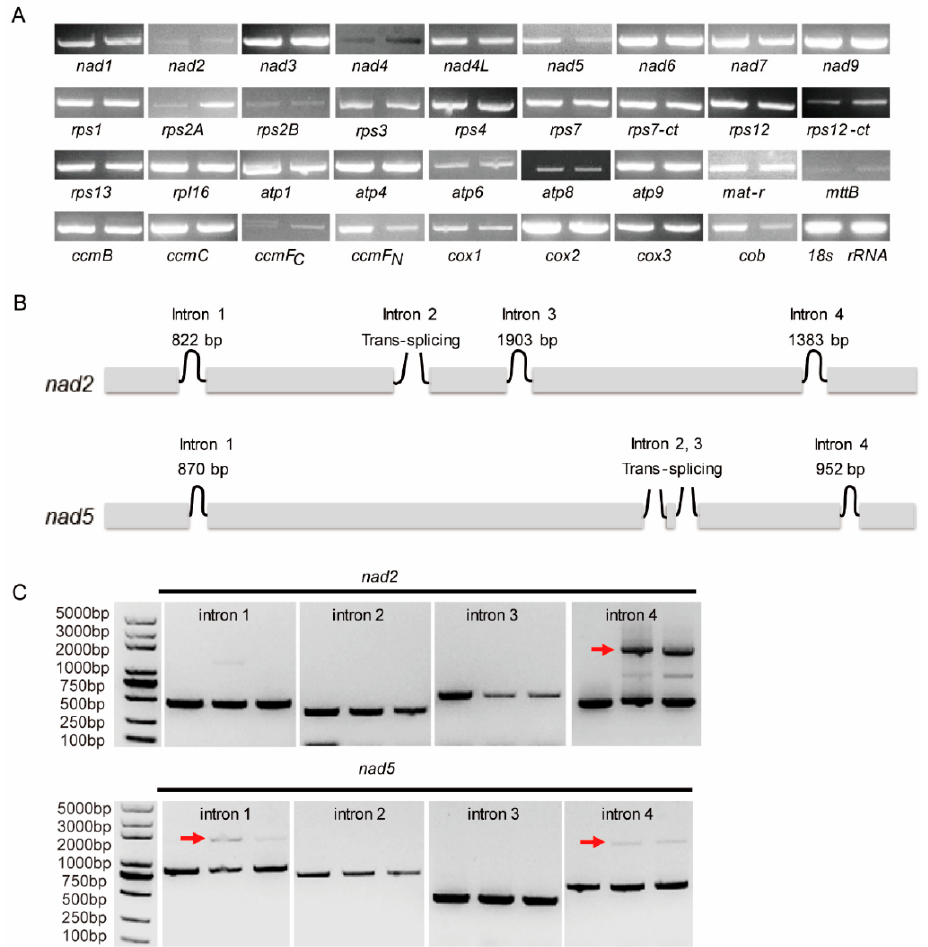
Figure 4. Intron splicing deficiency of nad2 and nad5 in ppr278 mutants. ( A ) RT-PCR analysis of 35 mitochondrion-encoded transcripts in WT (left) and ppr278-1 (right) plants. RNA was isolated from WT and ppr278-1 endosperm from the same segregating ear at 12-DAP. 18S rRNA served as an internal control. ( B ) Structures of the maize mitochondrial genes nad2 and nad5 . ( C ) RT-PCR analysis of nad2 and nad5 intron splicing efficiency in WT (left), ppr278-1 (middle), and ppr278-2 (right) plants. A DNA marker is shown in the farther left lane. Red arrows indicate abnormal splicing in the ppr278-1 and ppr278-2